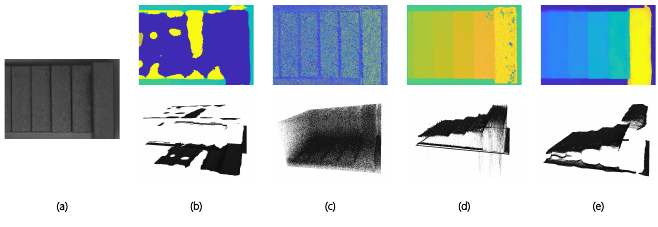
Figure 6. Standard gauge block results. The upper row is depth map and the lower is 3D point cloud.